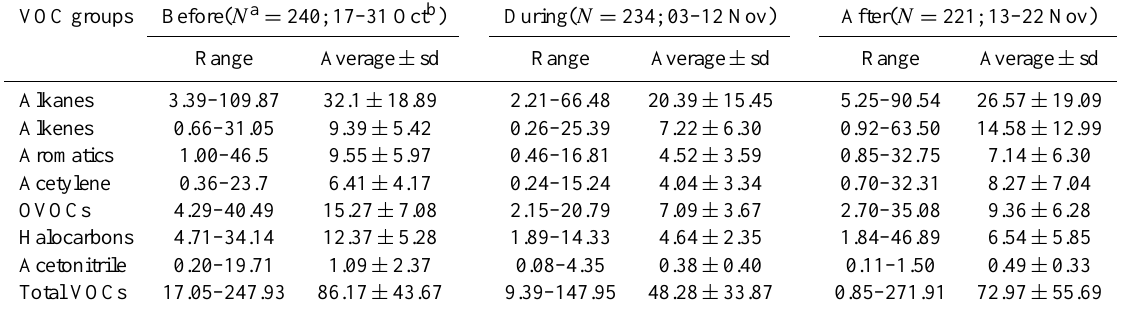
Table 1. Volatile organic compound (VOC) mixing ratios (ppbv), measured in Beijing. VOC groups